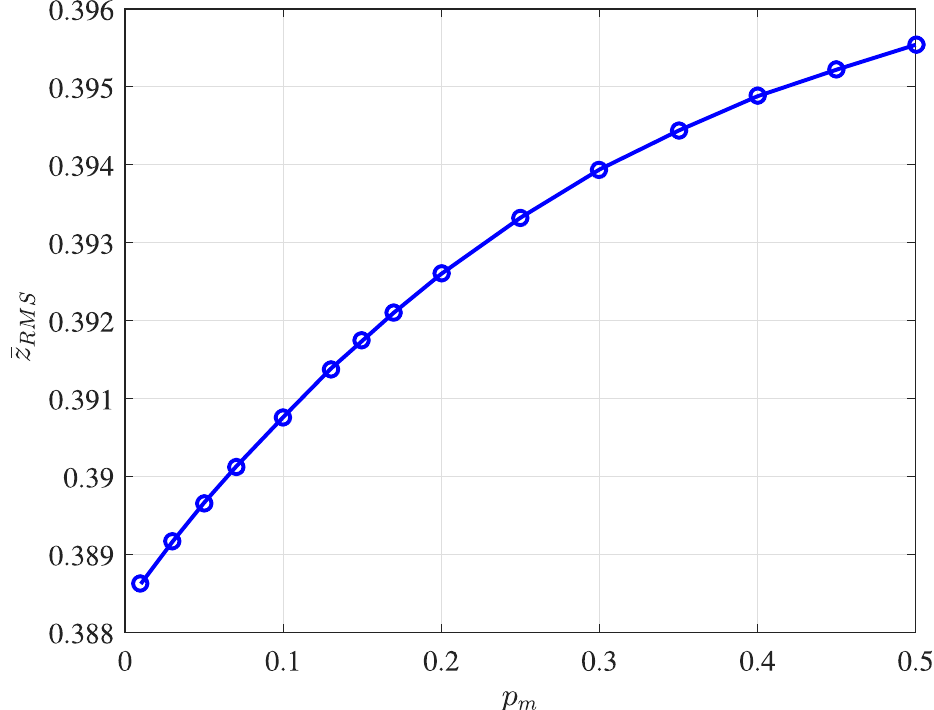
Figure 10. Relationship between the wind velocity and undesired oscillation.